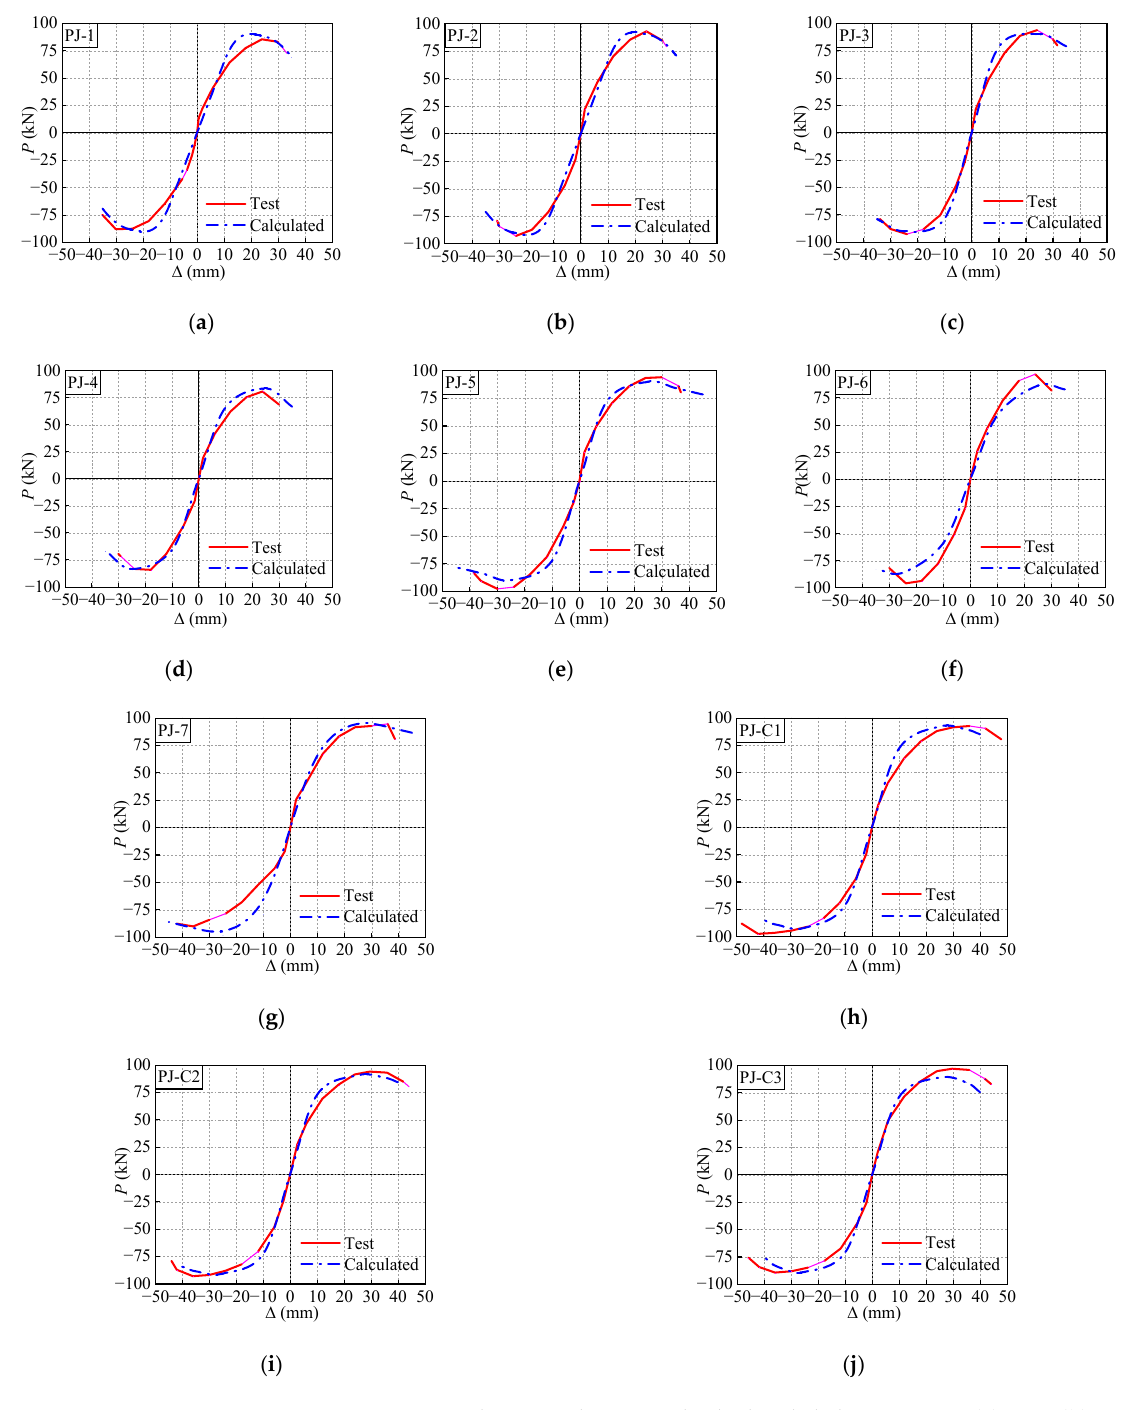
Figure 16. Comparison between the test and calculated skeleton curves. ( a ) PJ ‐ 1. ( b ) PJ ‐ 2. ( c ) PJ ‐ 3. ( d ) PJ ‐ 4. ( e ) PJ ‐ 5. ( f ) PJ ‐ 6. ( g ) PJ ‐ 7. ( h ) PJ ‐ C1. ( i ) PJ ‐ C2. ( j ) PJ ‐ C3.